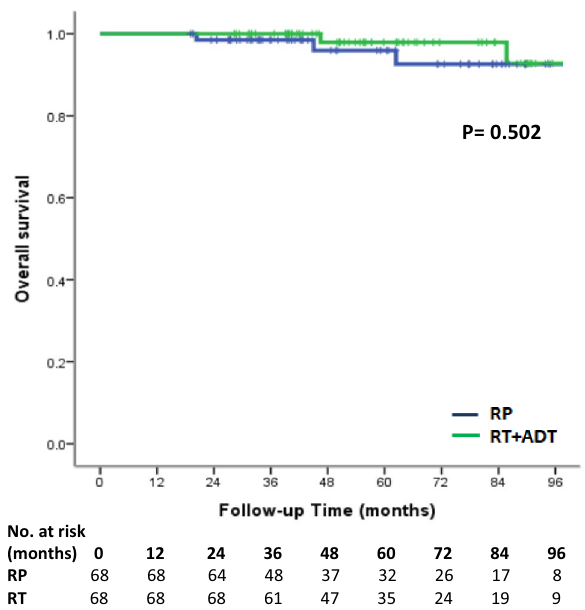
Figure 4. Kaplan–Meier analysis of overall survival in propensity-score matched patients. For each treatment group, we generated Kaplan–Meier survival curves for overall survival according to management method, and we also calculated a log-rank test to evaluate the association of overall survival with different management method among propensity-score matched patients.